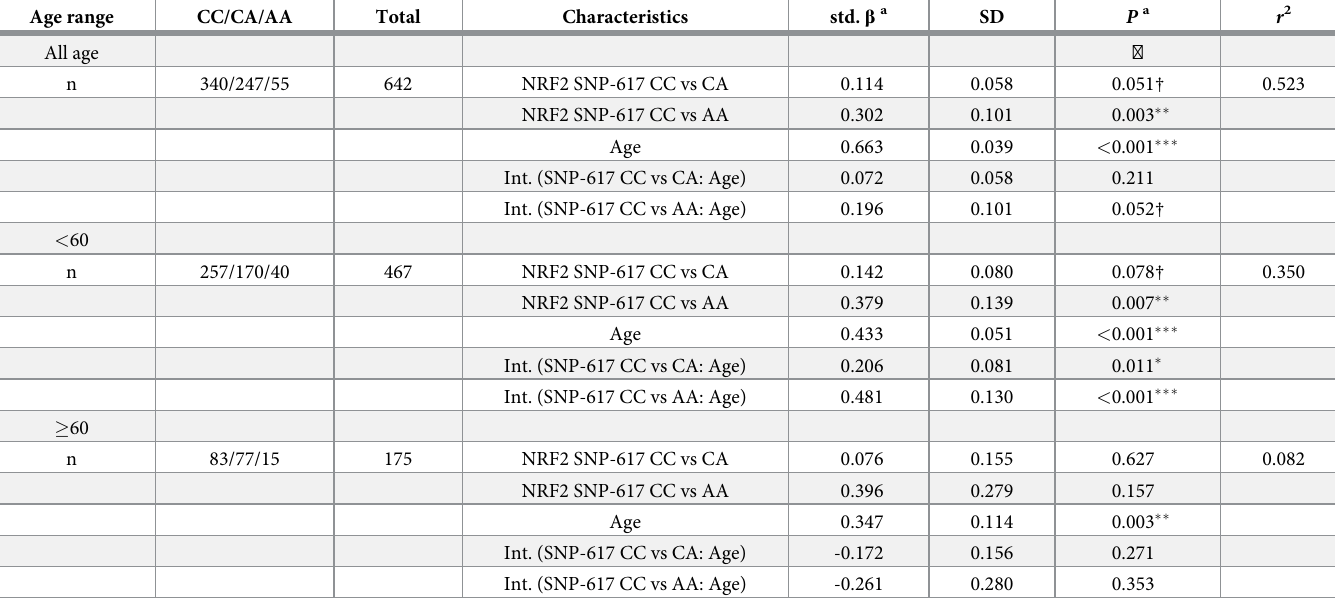
Table 3. Standardized multiple linear regression analysis of NRF2 SNP − 617, baPWV and